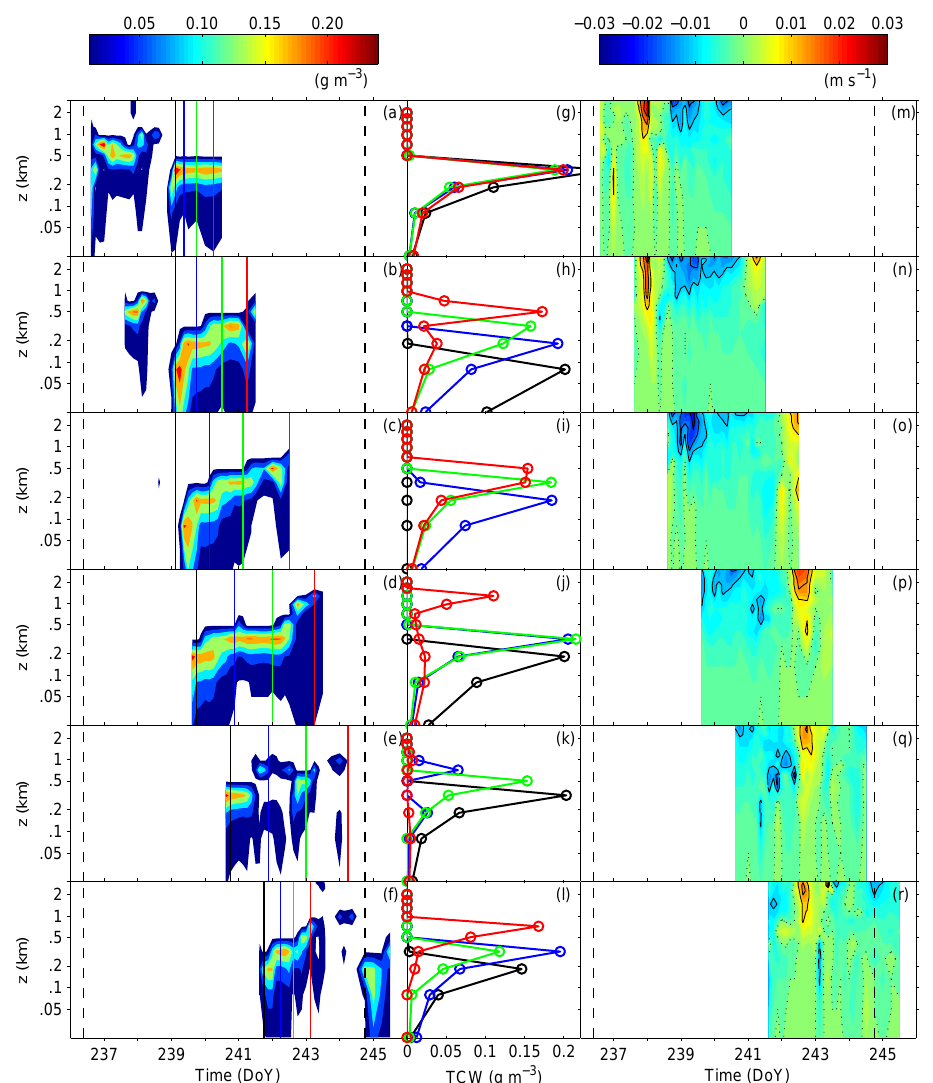
Fig. 7. Total cloud water concentrations (a–f) , total cloud water profiles (m–r) and vertical velocity (g–l) and for six 4-day operational forecasts, initialised daily at 12:00UTC. The colours of the total cloud water concentration profiles in panels (g) to (l) relate to the times marked by the coloured lines in panels (a) to (f) . Note the logarithmic y-axis scale on all